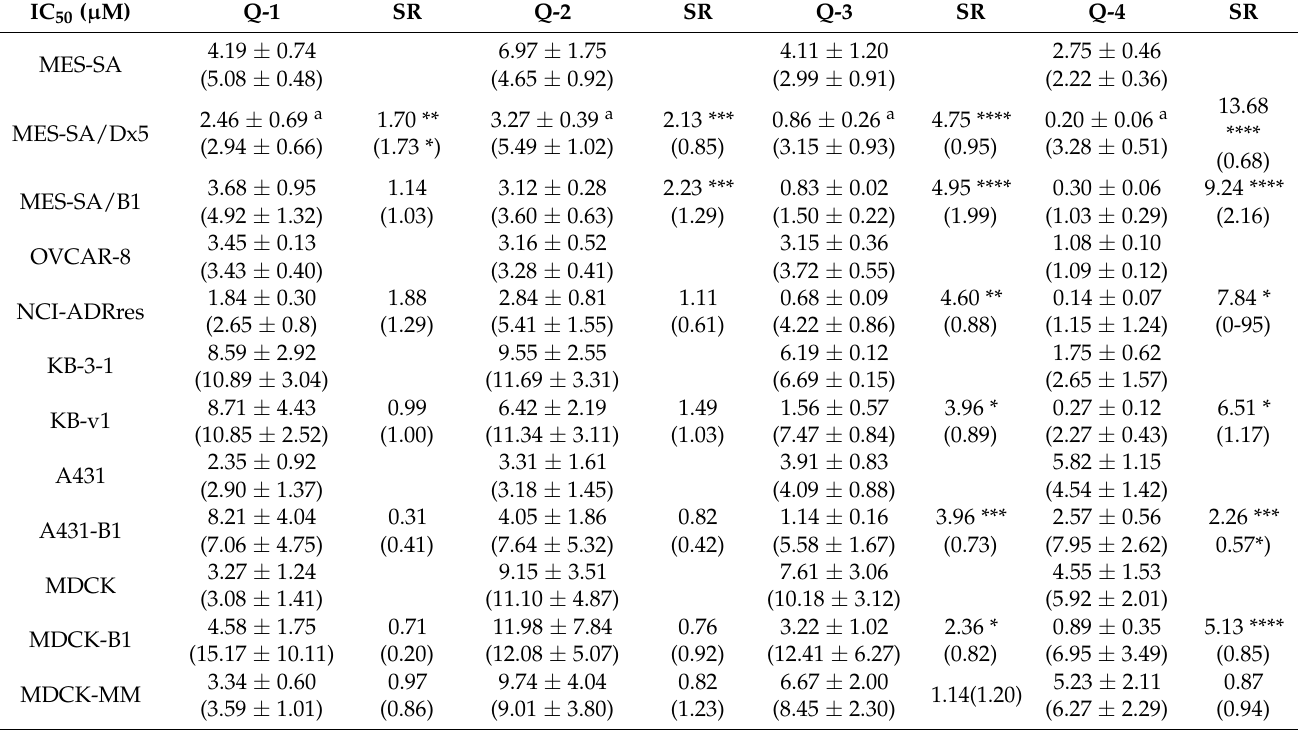
Table 1. Toxicity of the studied compounds in a panel of multidrug resistant (MDR) cell lines. IC 50 values (50% toxicity) are shown in µ M, as determined by MTT assays performed in the absence or presence of 1 µ M Tariquidar (values in brackets). MDR-selective toxicity of a compound is expressed as the fraction of IC 50 values obtained in Pgp negative vs. positive cells (selectivity ratio, SR) determined from 3–18 independent experiments. A compound is considered to possess MDR-selectivity at SR > 2. Significance was calculated using unpaired t -tests; results are given as *: p ≤ 0.05, **: p ≤ 0.01, ***: p ≤ 0.001, ****: p ≤